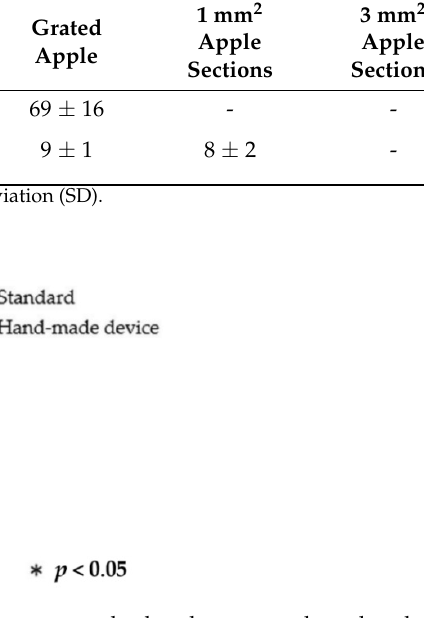
Figure 9. Comparison of the procedure time between a standard endoscope and our hand-made device for suctioning soft jelly and grated apple. *: p < 0.05.